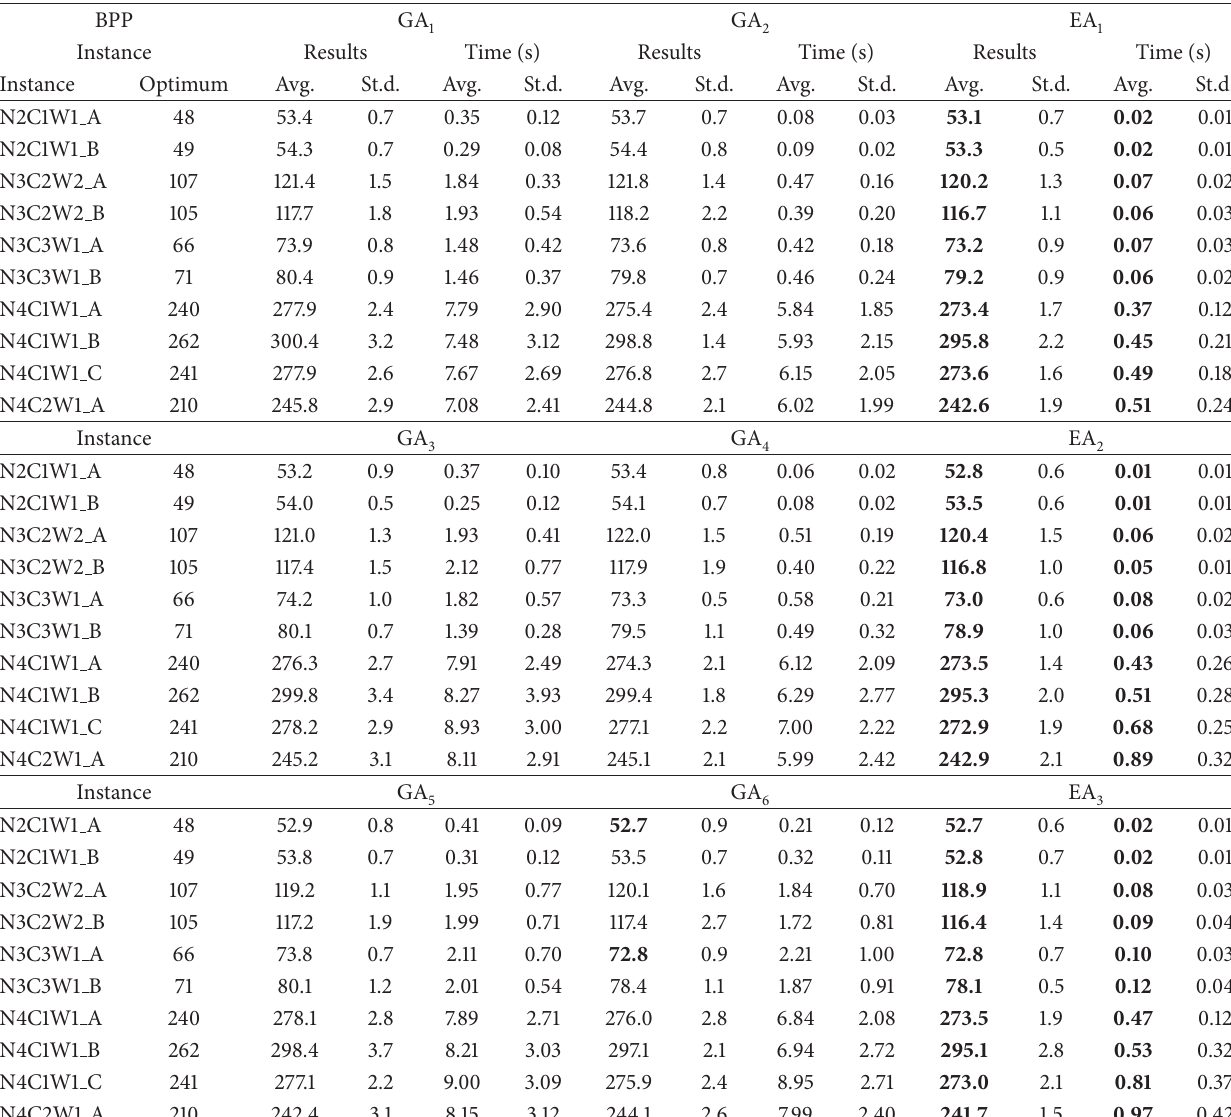
Table 11: Results and runtimes of the nine techniques applied to the BPP. For each instance, the results, average runtime, and their standard deviations are